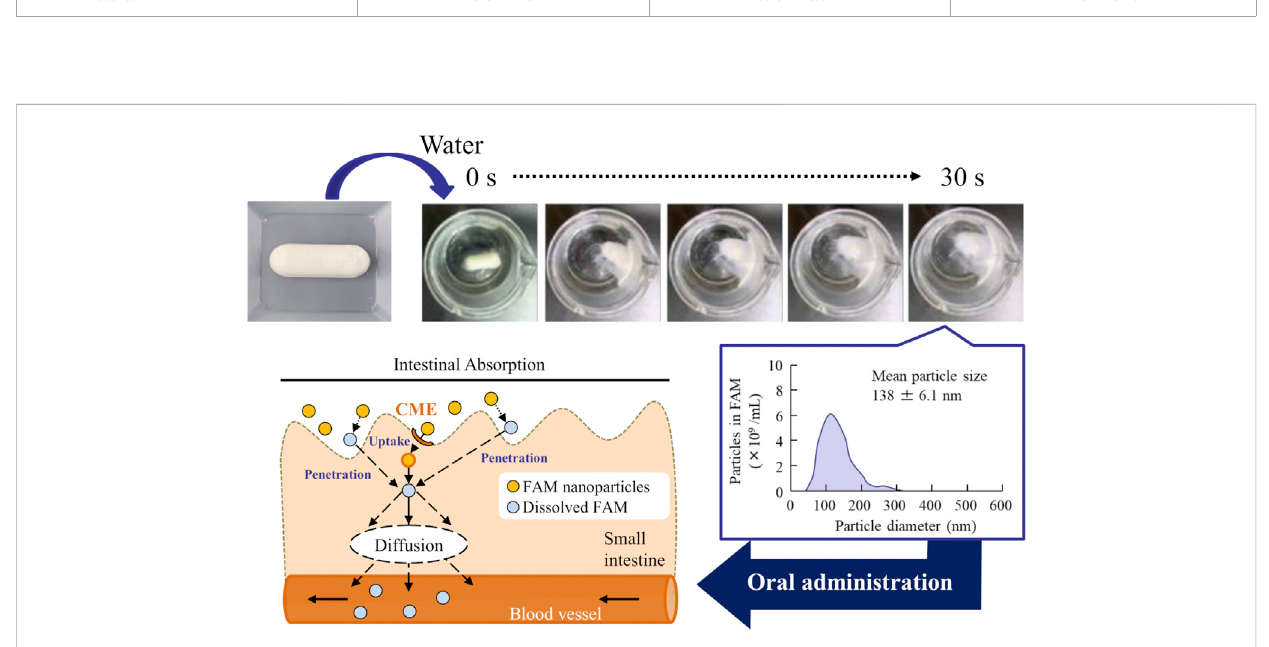
FIGURE 7 Mechanism for intestinal absorption after the orally administration of FAM-NP table.